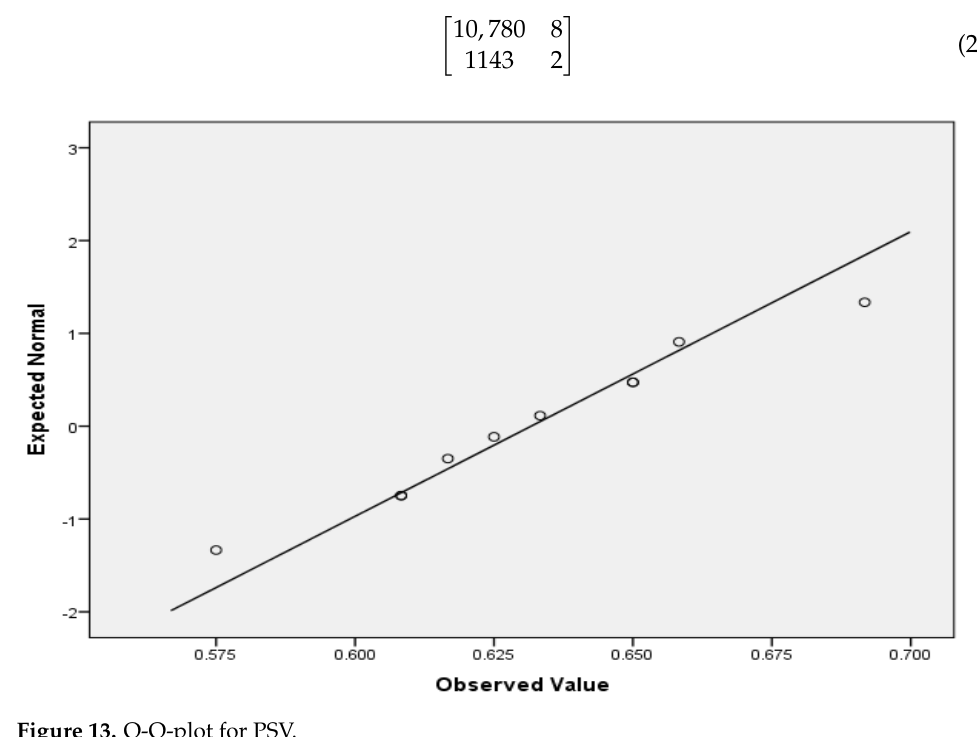
Figure 13. Q-Q-plot for PSV. Table 6. Experiment 2 evaluation